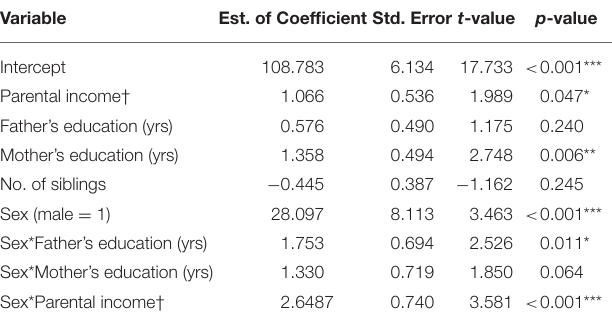
TABLE 2 | Effects of parental income† on respondent’s income†.